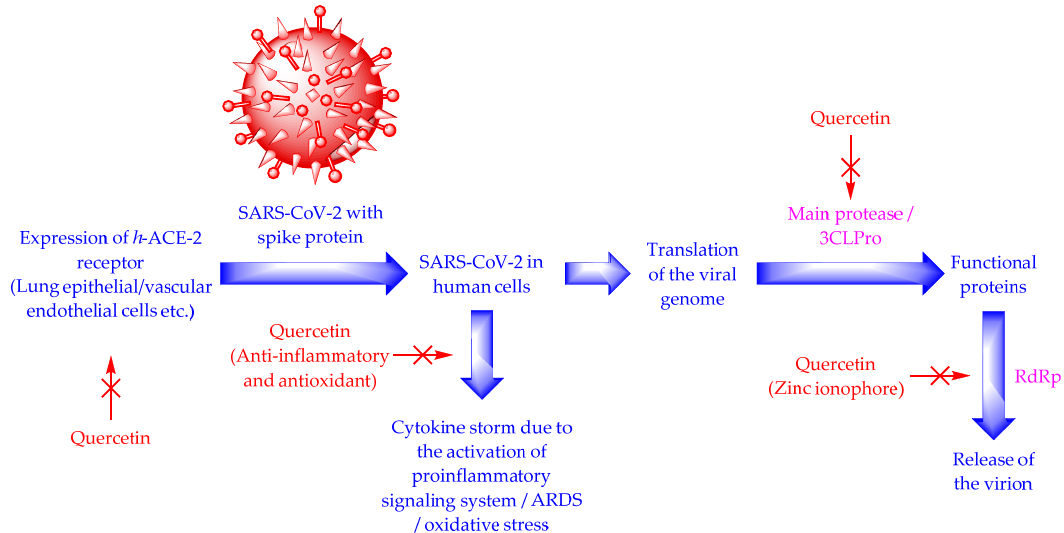
Figure 3. Life cycle of SARS-CoV-2 and mechanism of action of quercetin [5,6,9,12,25–29].